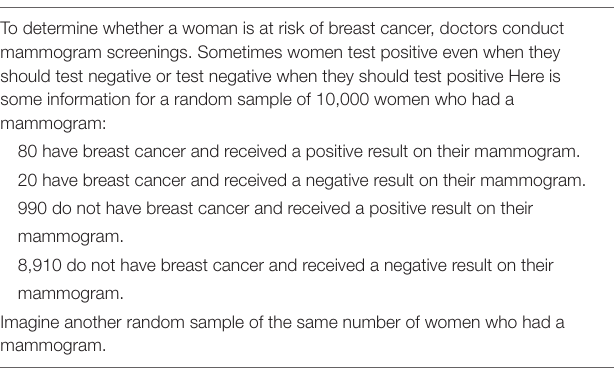
TABLE 7 | Example presentations with no explicit organization for the mammography problem. Incongruent condition-Focus problem with no explicit